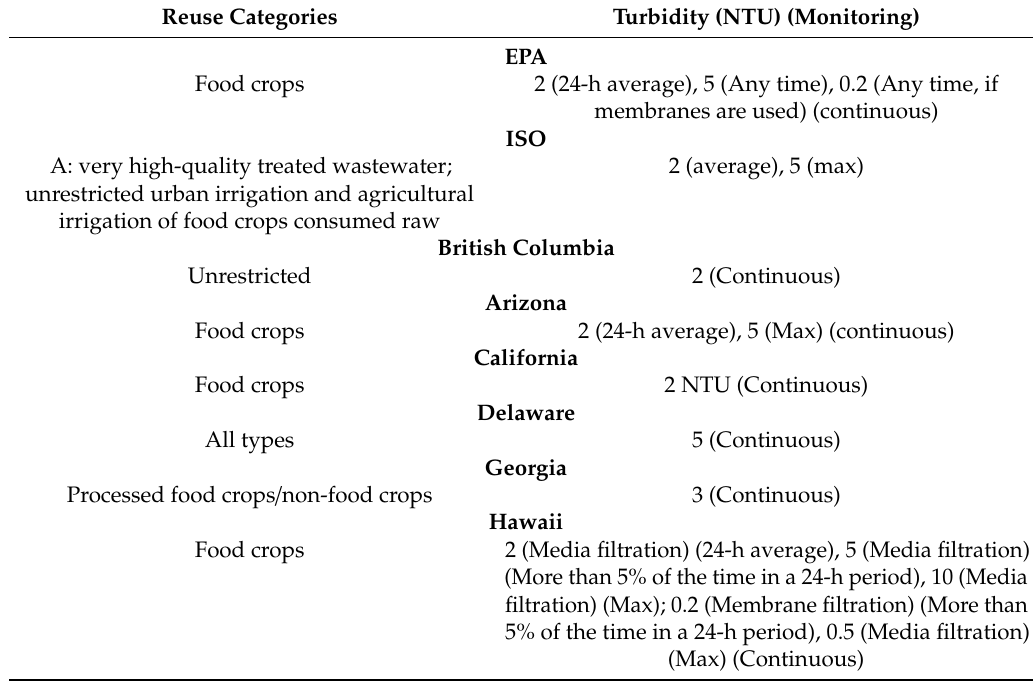
Table 15. Turbidity thresholds in agricultural water reuse regulations and